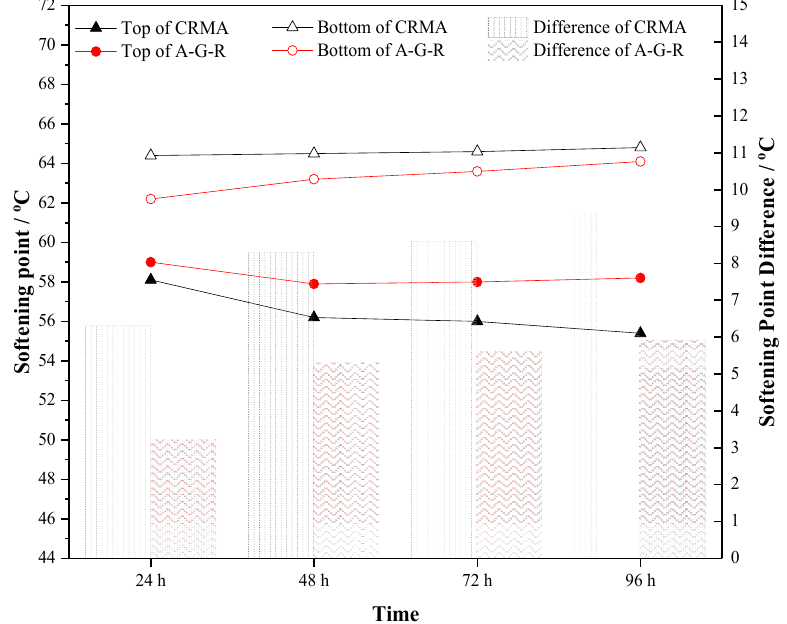
Figure 8. Softening point difference of CRMA and A-G-R.